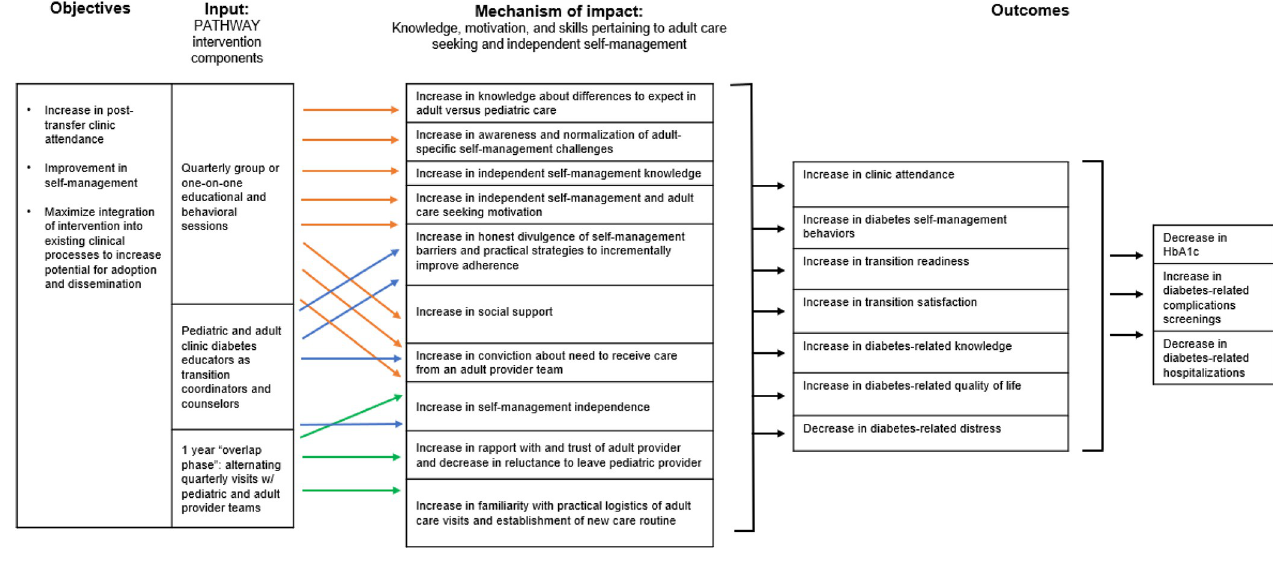
Fig 1. The PATHWAY intervention logic